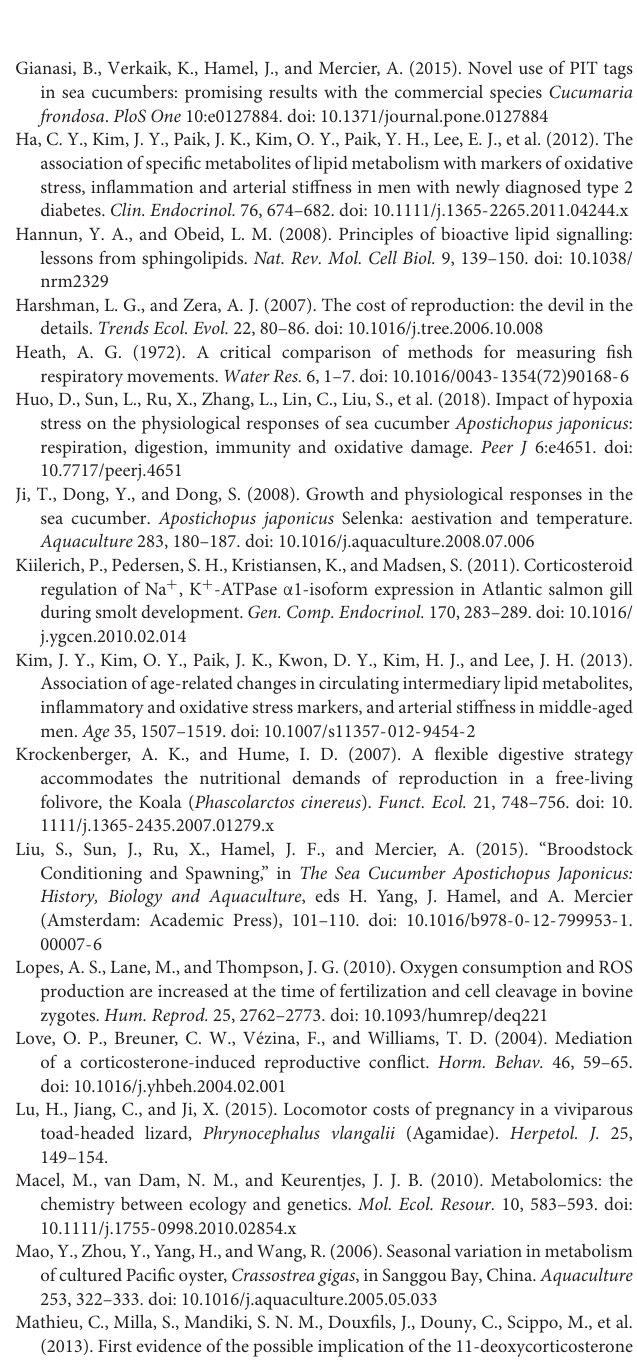
FIGURE S1 | The orthogonal projection to latent structures discriminant analysis (OPLS-DA) scores plot of respiratory tree metabolites from the non-breeding stage (blue squares) and the breeding stage (yellow triangles) in positive ion mode (A) and negative ion mode (B)